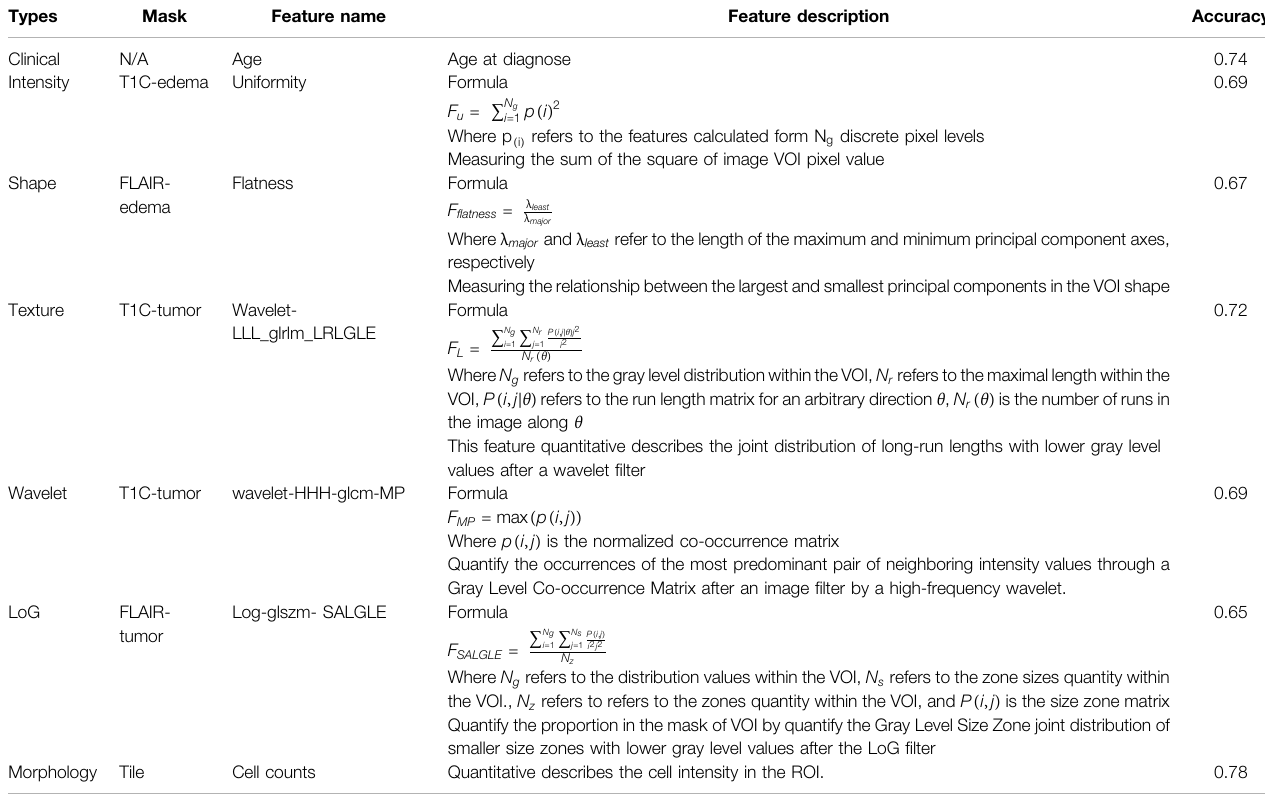
TABLE 2 | TOP-performing features in IDH status prediction by means of univariate analysis.